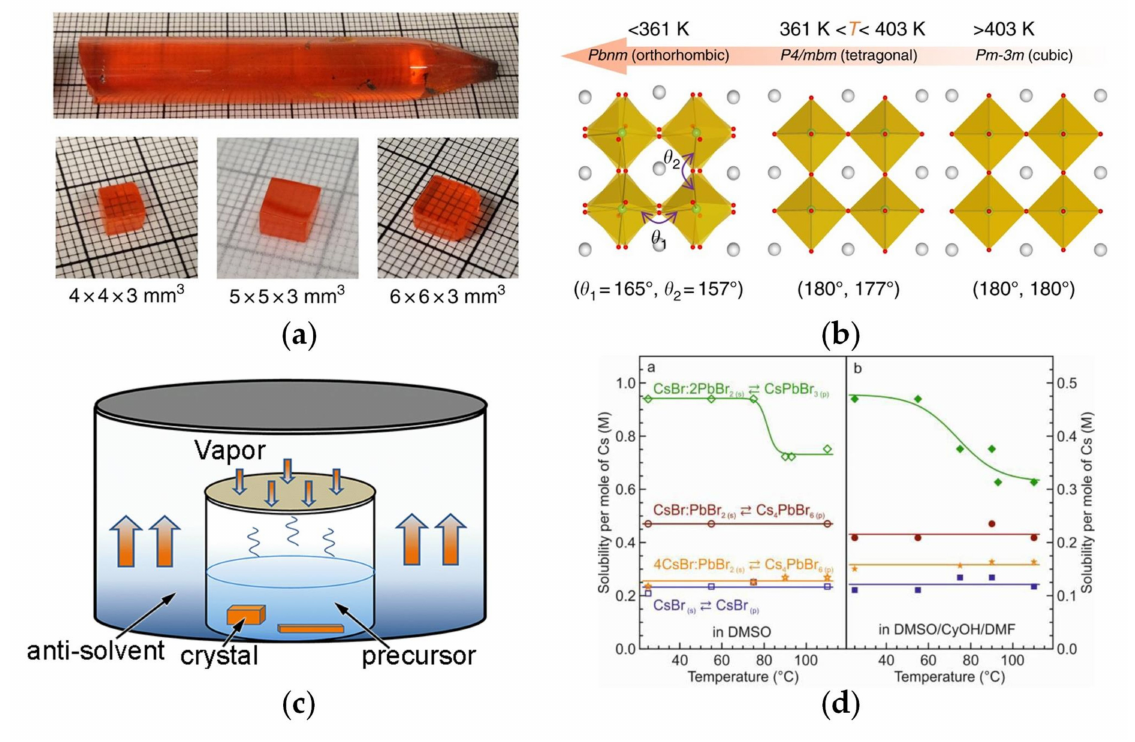
Figure 2. ( a ) Optical images of Bridgman-grown CsPbBr 3 PSCs. Adapted with permission from Ref. [64]. 2018, Springer Nature; ( b ) phase transition process of CsPbBr 3 at different temperature. Adapted with permission from Ref. [64] 2018, Springer Nature; ( c ) phase transition process of CsPbBr 3 at different temperature. Adapted with permission from Ref. [54]. 2017, American Chemical Society; ( d ) different solubility-temperature profiles in DMSO solvent and DMSO mixed solvent. Adapted with permission from Ref. [66]. 2016, American Chemical